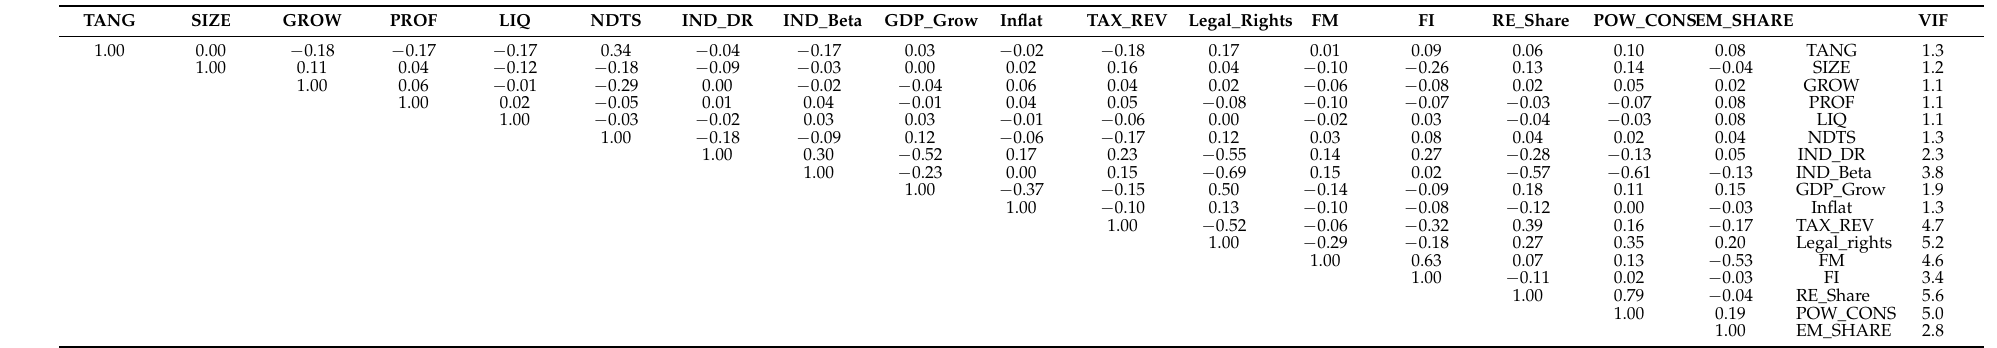
Table 3. Pearson correlation matrix for explanatory